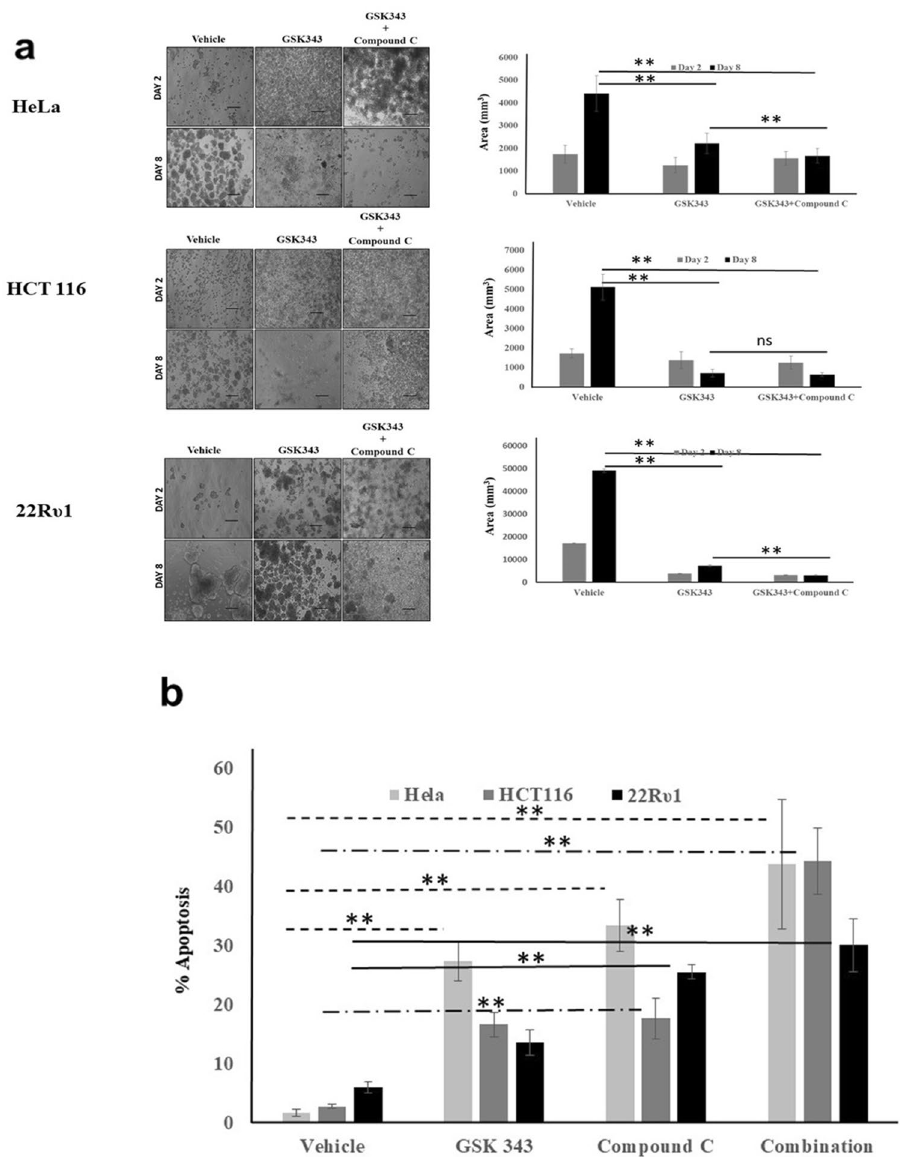
Figure 4. A combination of EZH2 and AMPK inhibitor synergize to reduce sphere-forming capability and induces cell death. ( a ) Cancer cells HeLa, HCT116, and 22Rυ1 were grown in low attachment plates, and E.C.M. detached cells were treated with different concentrations of GSK343 and Compound C for 2–8 days, and images were captured by Nikon inverted light microscope at ×40. Images were analyzed for size measurement using image J software (mean ± S.E.M., n = 8). A total number of 100 spheroids were quantified for size analysis; * P < 0.05. ( b ) Cancer cells HeLa, HCT116, and 22Rυ1 were grown in low attachment plates, and E.C.M. detached cells were treated with different concentrations of GSK343 and Compound C for 8 days, and apoptosis was quantified by using Annexin V/PI